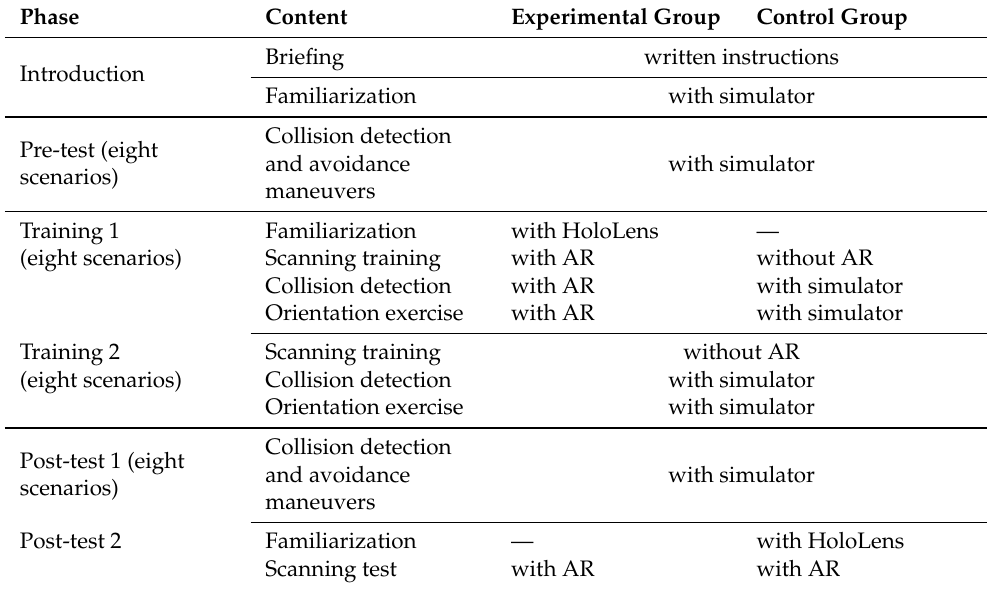
Table 1. Procedure for the experimental and control